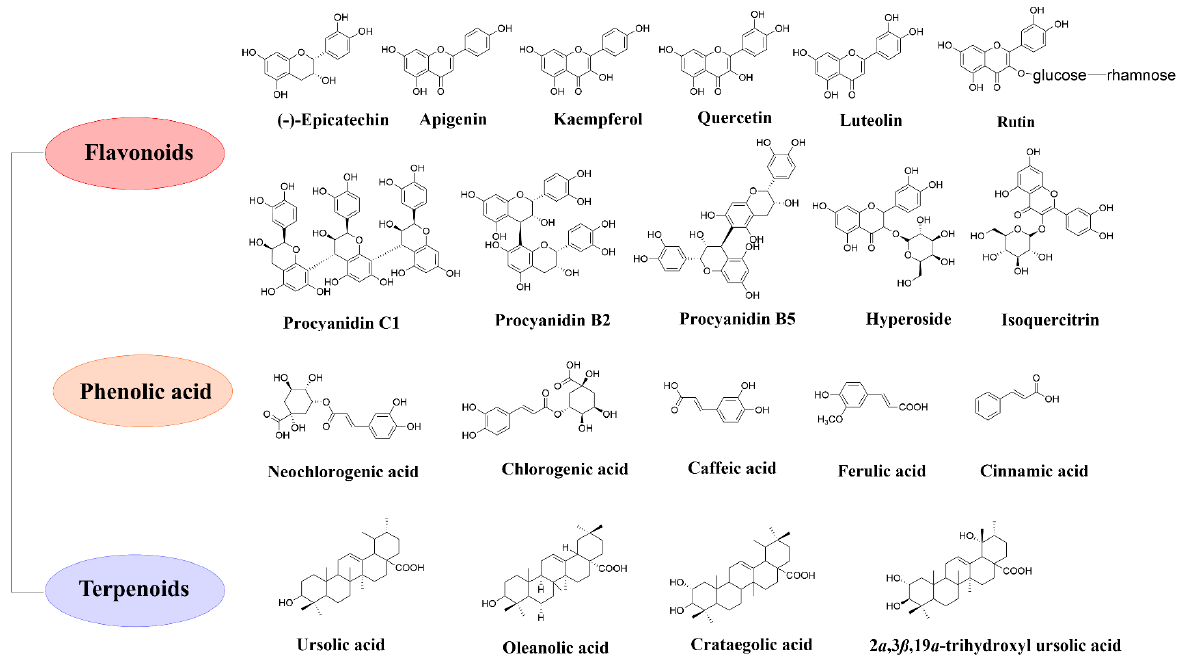
Figure 1. The main bioactive compounds of hawthorn. Table 2. Flavonoids identified from